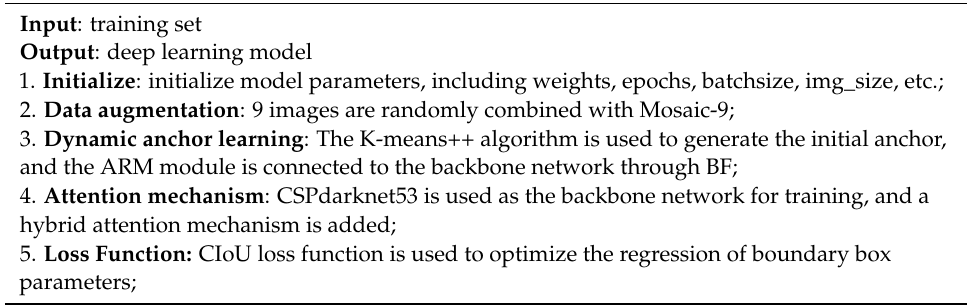
Algorithm 1. The proposed algorithm.